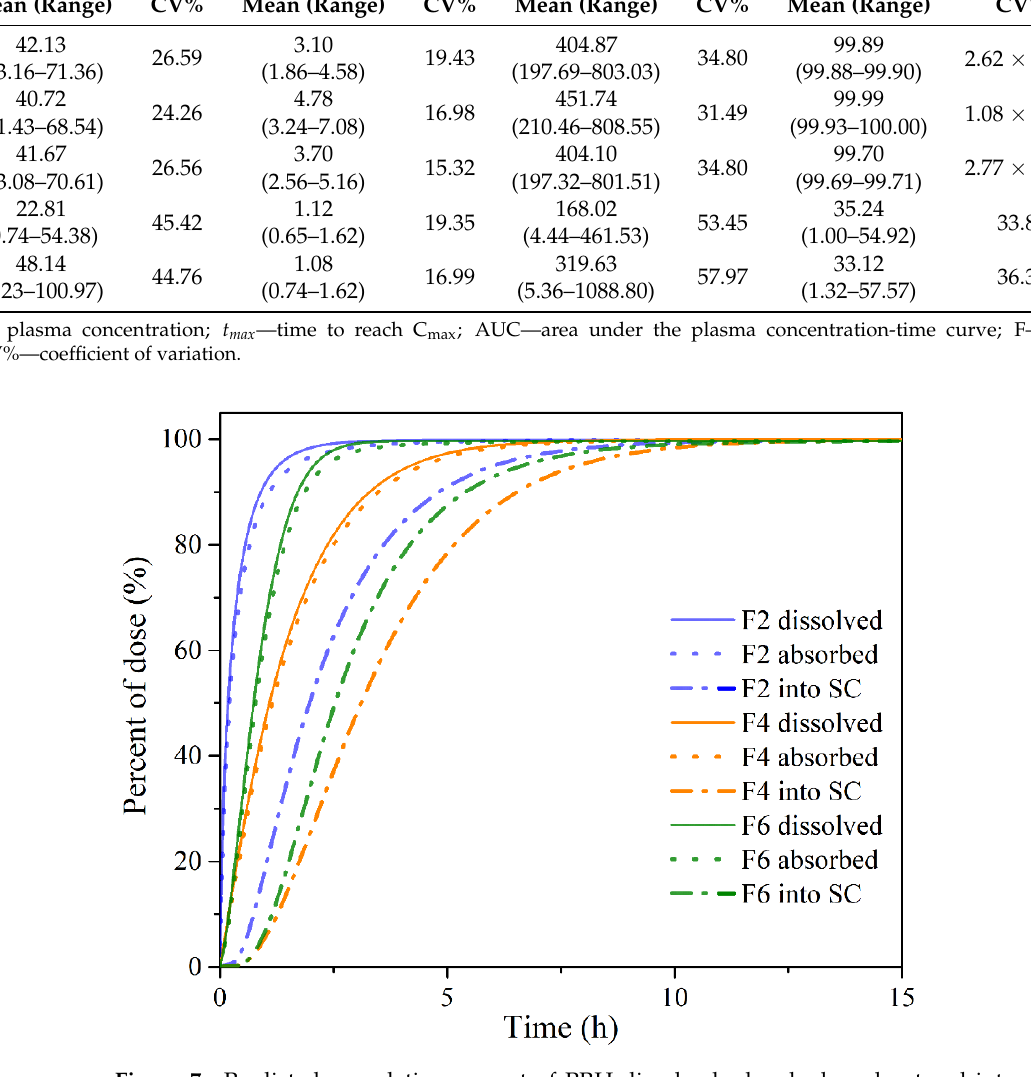
commercially available dose of PRH tablets for hypertrophic subaortic stenosis (thickened heart muscle) for adults is 20 to 40 mg three or four times per day [75]; for arrhythmias, hypertrophic obstructive cardiomyopathy and anxiety tachycardia, the dose for